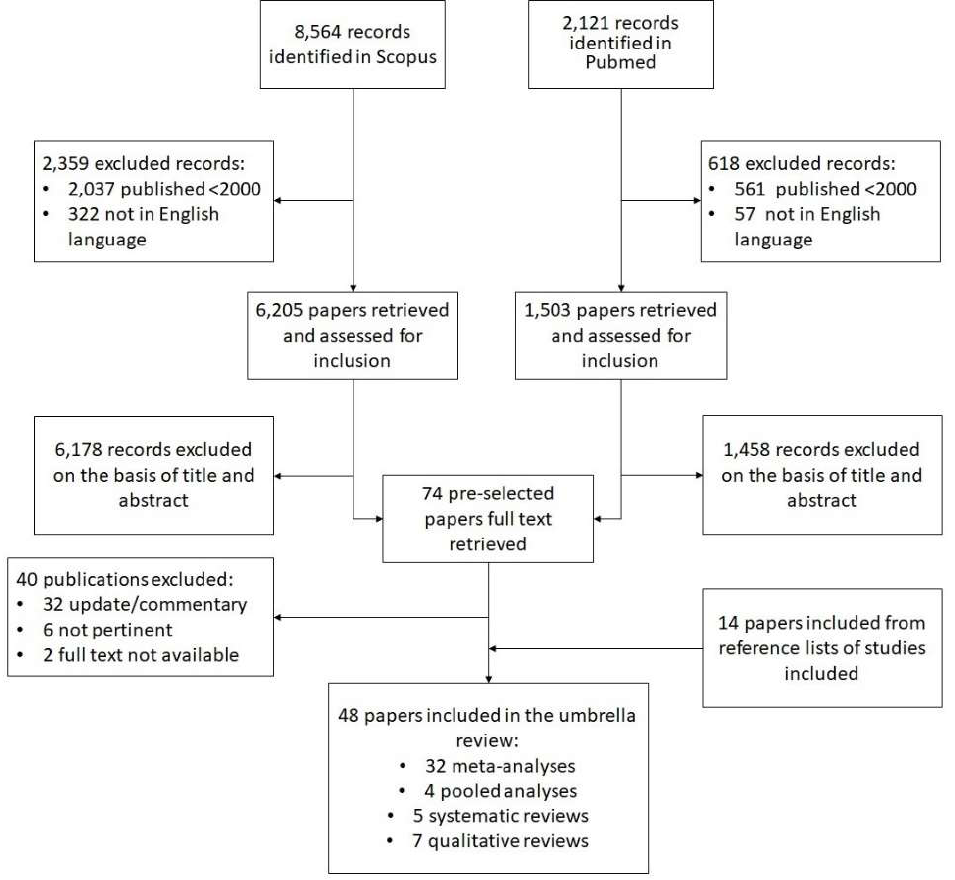
Figure 1. The research strategy used to identify the articles for the umbrella review.